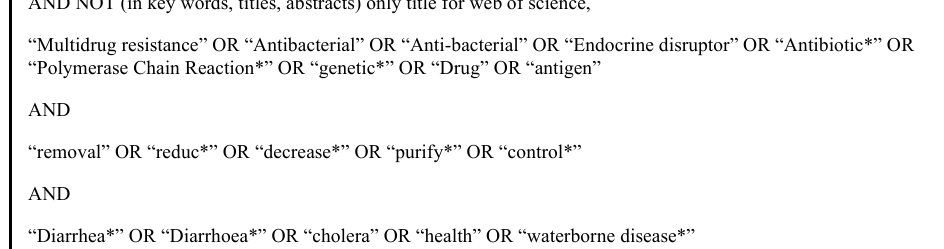
Figure 1. Systematic review search terms (asterisks * indicate search term truncation.).